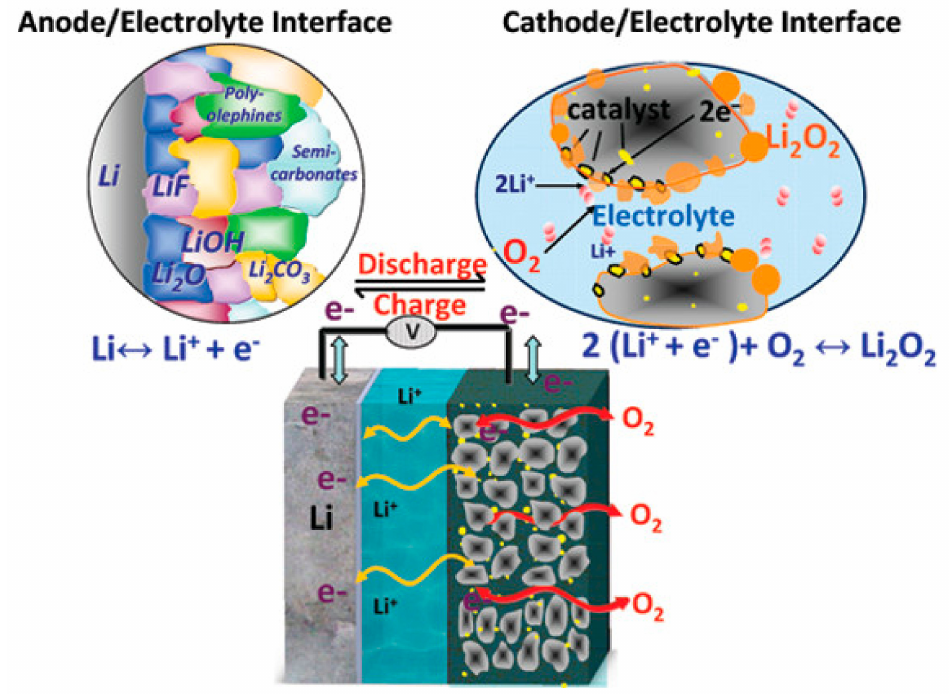
Figure 1. The architecture of LABs. Reprinted with permission from ref. [4]. Copyright 2010 American Chemical